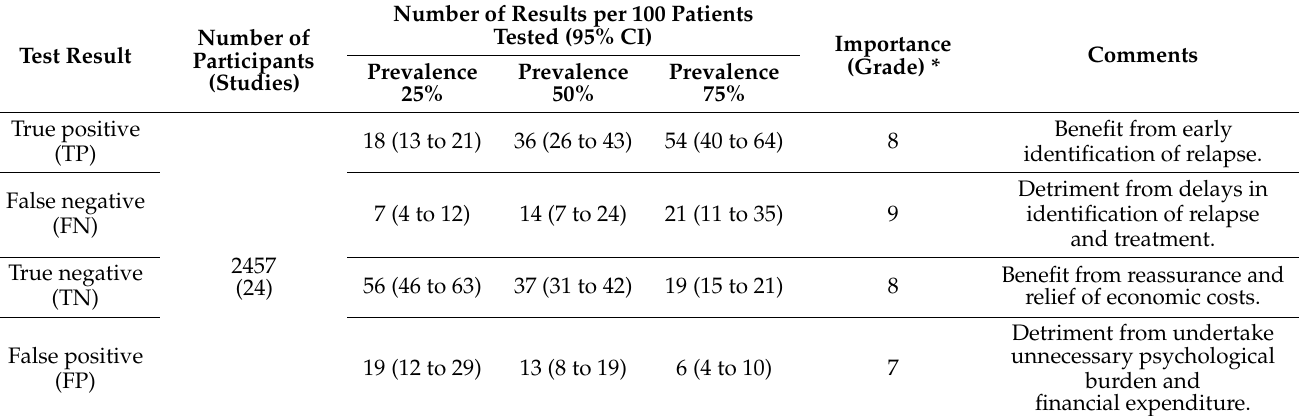
Table 4. Effect of pooled sensitivity and specificity of fecal calprotectin on patients.